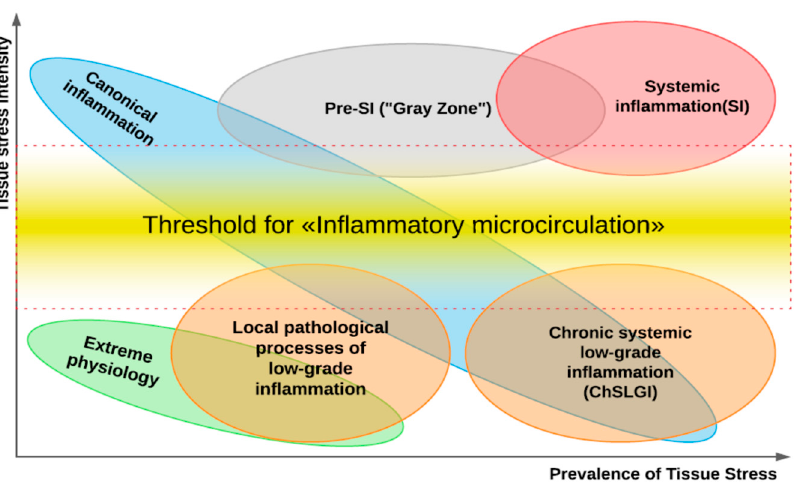
Figure 2. Tissue stress and general pathological processes (from Gusev E. et al., 2021). Note: The ratio of intensity to prevalence of damaging factors initiating a ‘response’ in the form of tissue pro-inflammatory stress—a common pathogenetic underpinning of all pathological processes—can be used to distinguish three ‘big’ general pathological processes (classical inflammation, systemic inflammation, and ChSLGI). The figure shows that the systemic manifestations of classical inflamma- tion and ChSLGI may be comparable in terms of the localization and intensity of pro-inflammatory responses, requiring additional diagnostic methods to separate